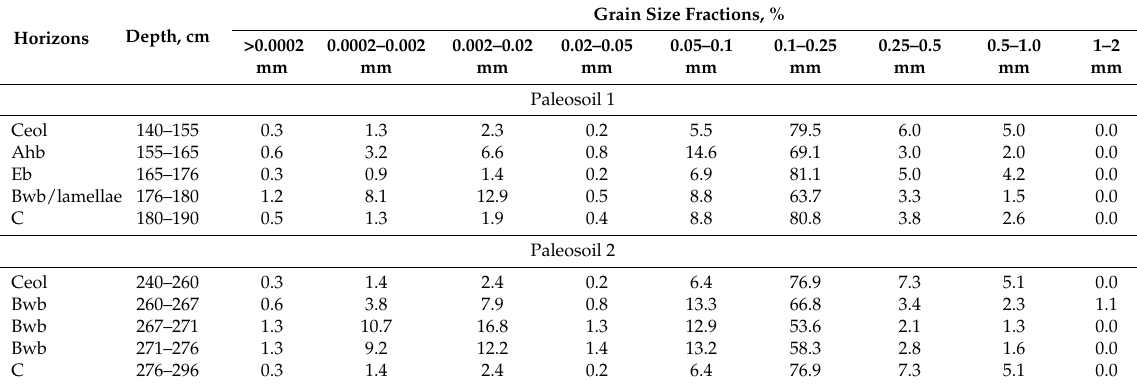
Table 1. Texture of buried soils.